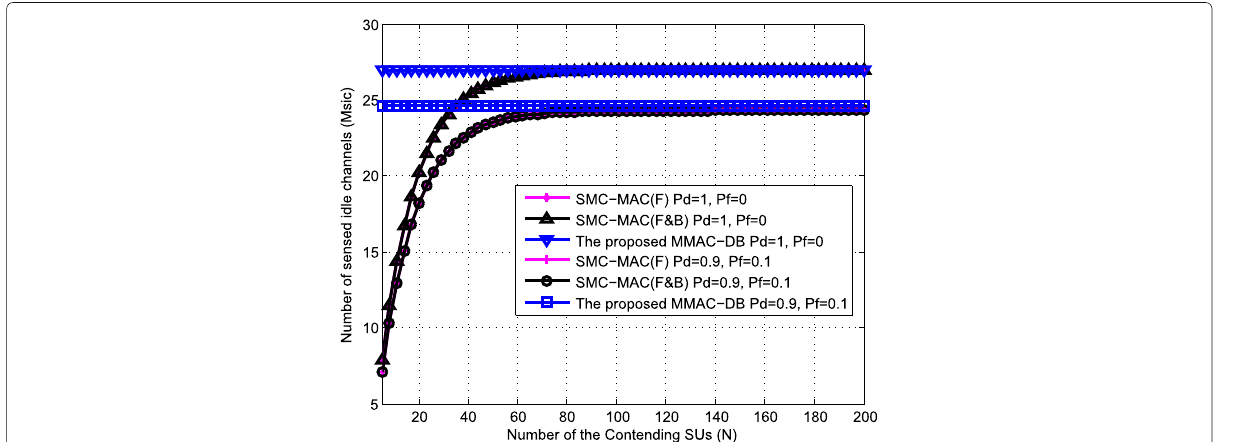
Fig. 11 Number of sensed idle data channels with M = 30, α = 0.1. Sensed idle data channels analysis for scene 3